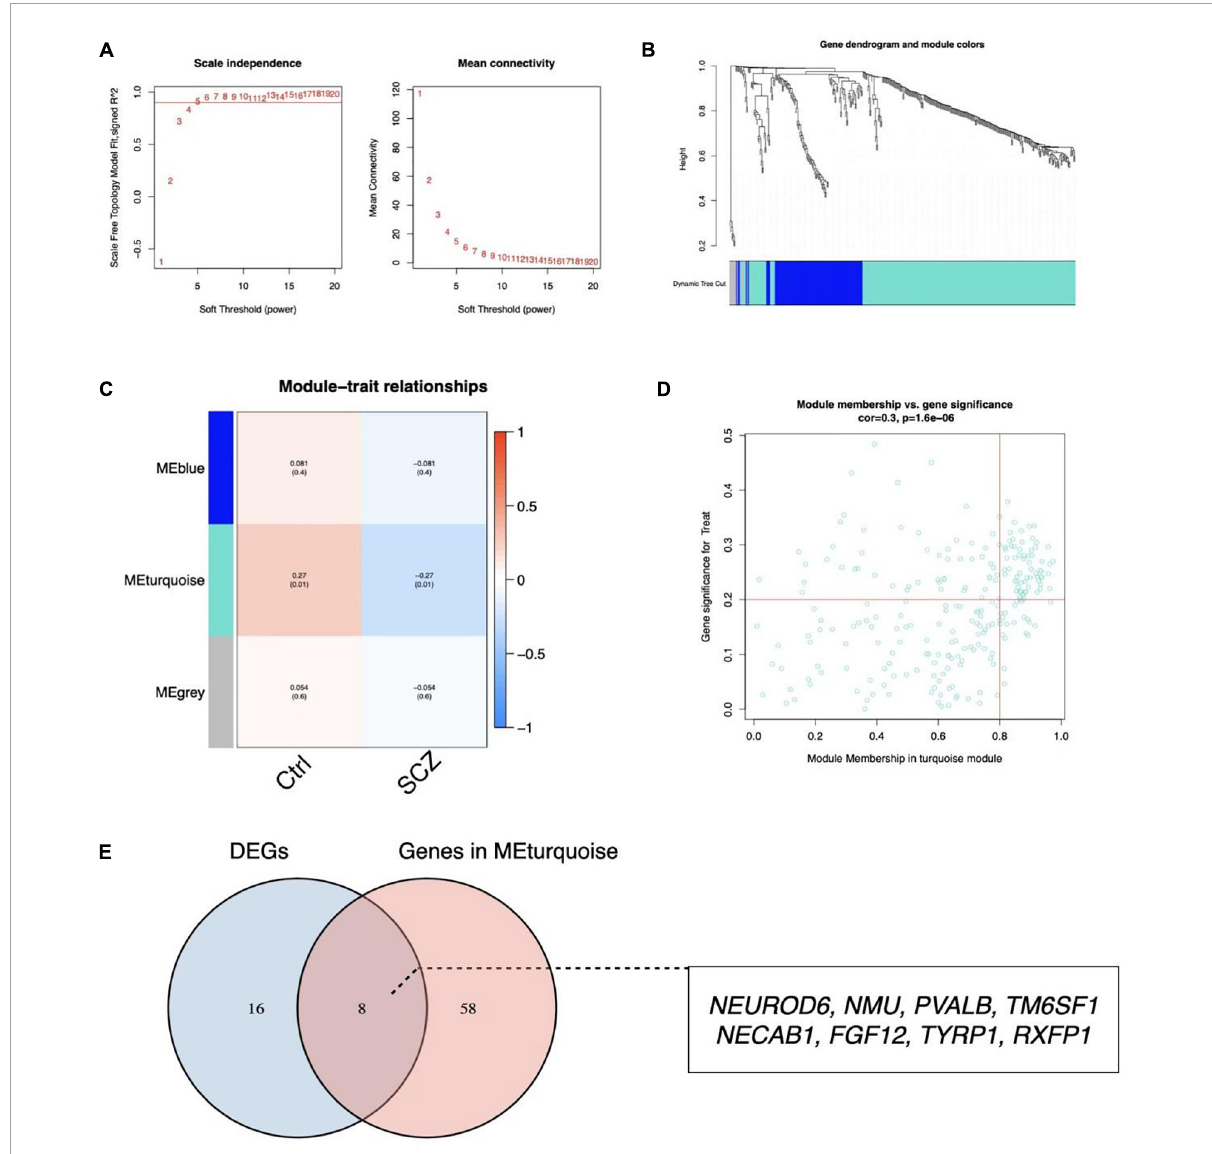
FIGURE5 Identification of critical modules by WGCNA. (A) Scale-free fit index and mean connectivity for different soft-thresholding powers. (B) Topological overlap dissimilarity aggregation of DEGs clusters. (C) Module-feature correlations Each row represents a module list, whereas each column represents a clinical characteristic. The first line of each cell includes the associated correlation, while the second line gives the P -value. (D) Scatter plot of the turquoise module. (E) Venn diagram for overlapped genes.